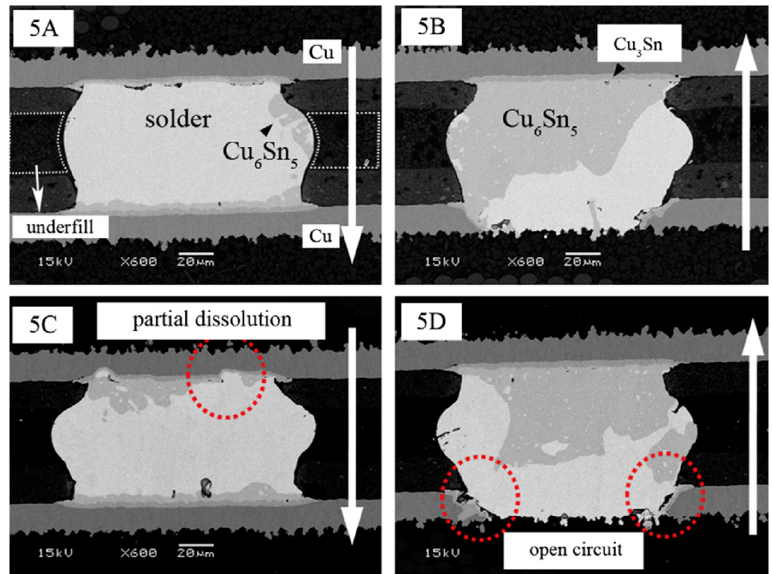
Figure 9. Microstructural changes in solder bumps after EM test for 98 h, Reprinted with permission from Ref. [46] Copyright 2011 Elsevier.